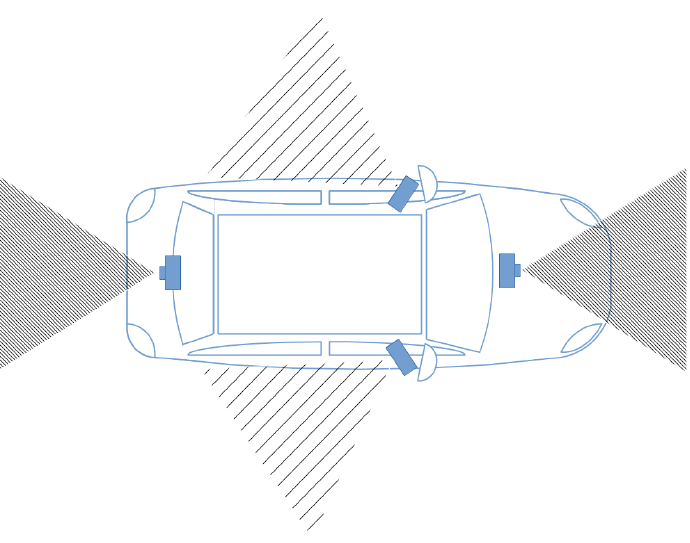
Figure 2. Illustration of the wireless sensors being placed in areas of interest for the